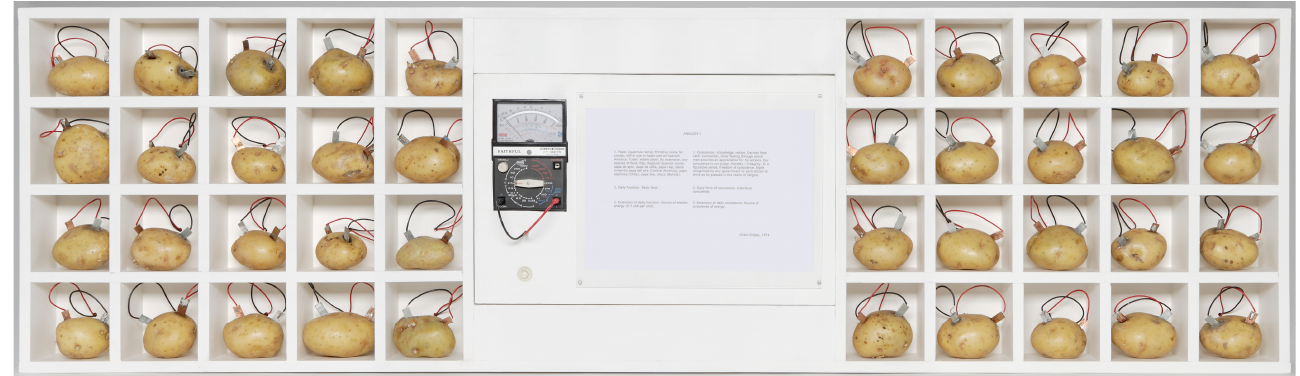
Figure 2. Victor Grippo, Analogía I , 1970–1971, electric circuits, electric meter and switch, potatoes, ink, paper, paint, and wood. Dimensions: 47 × 156.2 × 10.3 cm (18 ½ × 61 ½ × 4 1/16 in.). Harvard Art Museum (2010)/Fogg Museum, Richard Norton Memorial Fund and gift of Leslie Cheek, Jr., © The Estate of Victor Grippo, Photo © President and Fellows of Harvard College, 2010.3.